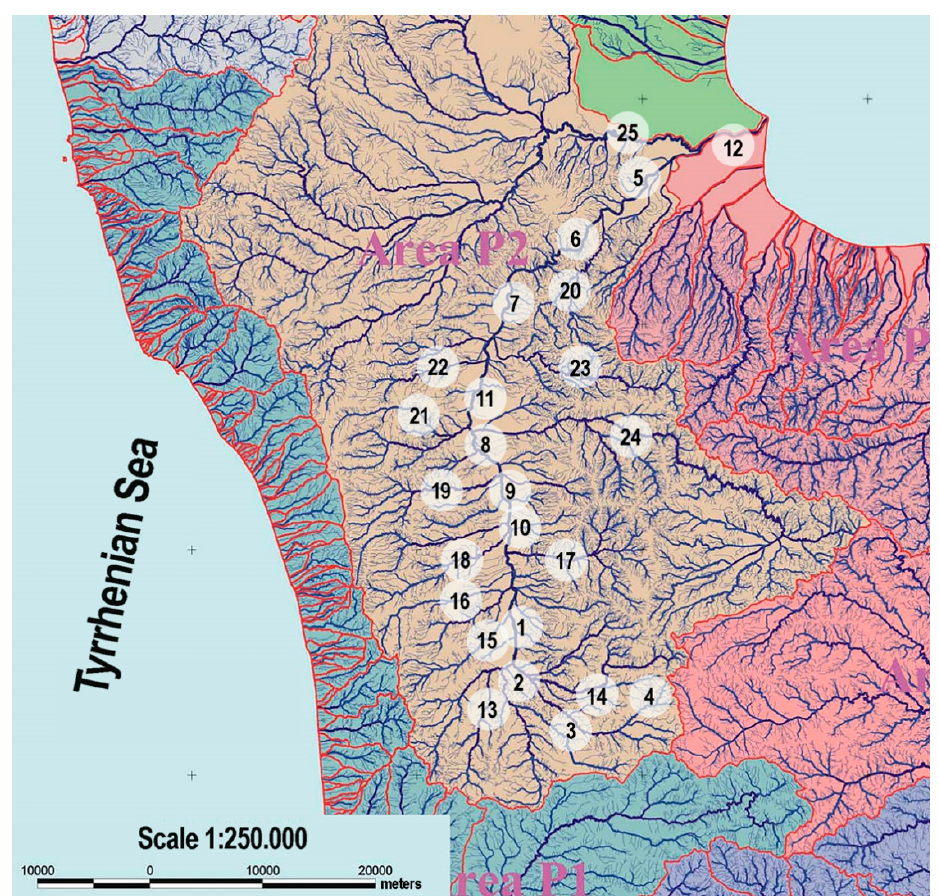
Figure 1. Geographical area showing the sampling sites.